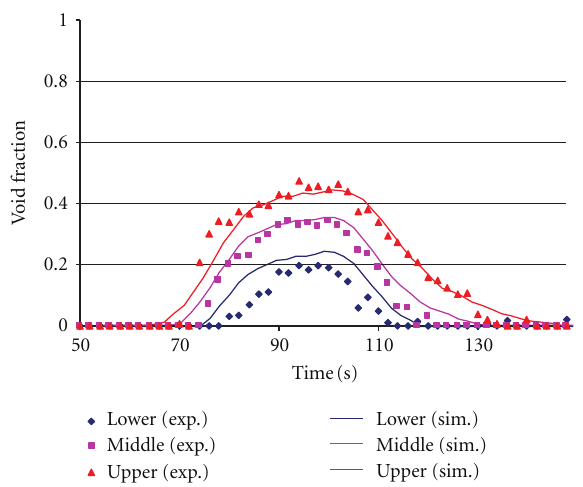
Figure 16: Void fraction comparison for inlet temperature increase transient.